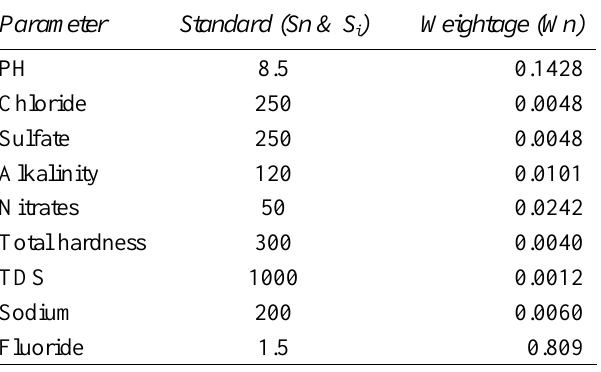
Table 2: Water quality parameters, their ICMR/WHO standards, and assigned unit weights